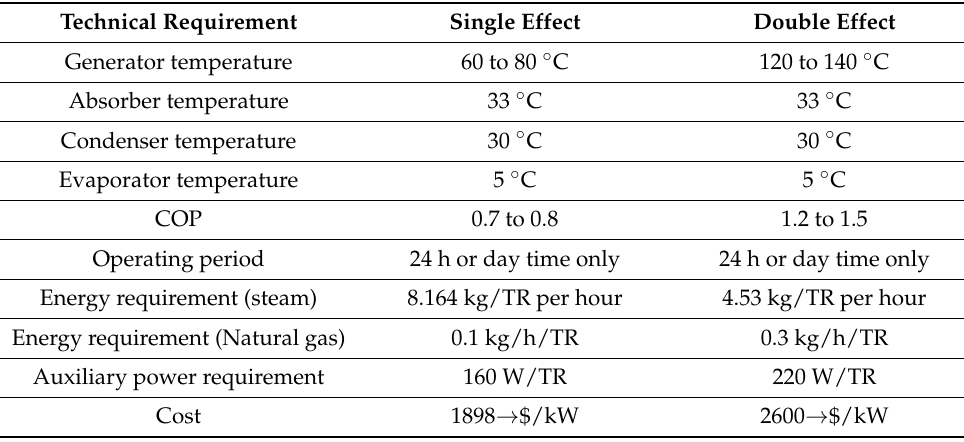
Table 3. Requirements of single and double effect VAR cooling system.